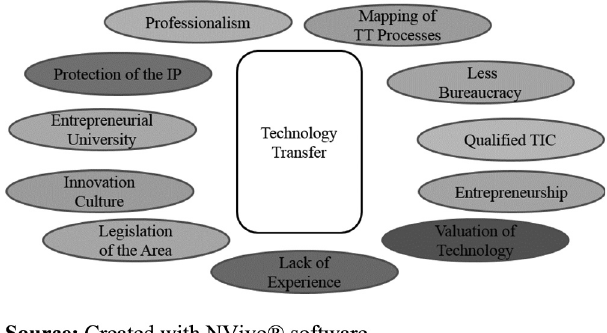
Figure 3. Main aspects related to the